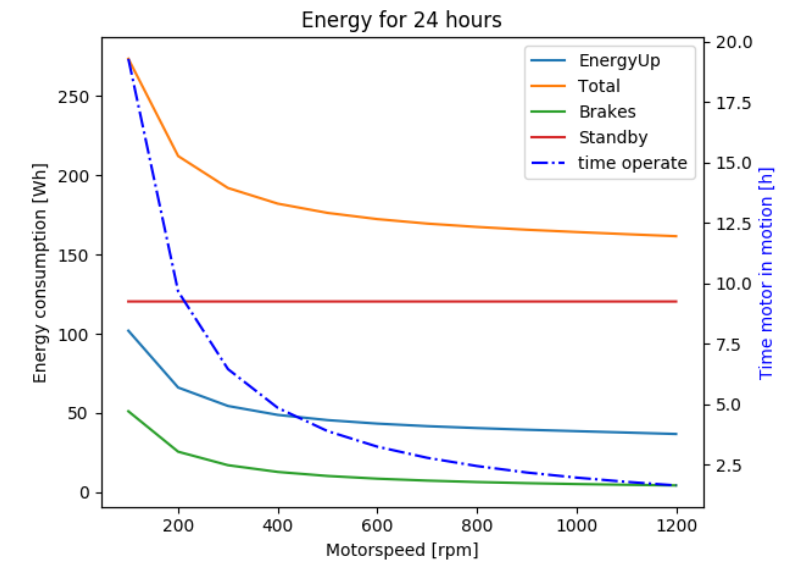
Figure 14. The analysis of the energy required by the motor and the brake and the standby power for the 19-day period analyzed (as in Figure 11). The dashed blue line shows the total time required to turn the motor. The green line shows the energy required to release the brake when the motor turns. The red line shows the standby energy, which is approximately the same throughout the test period.